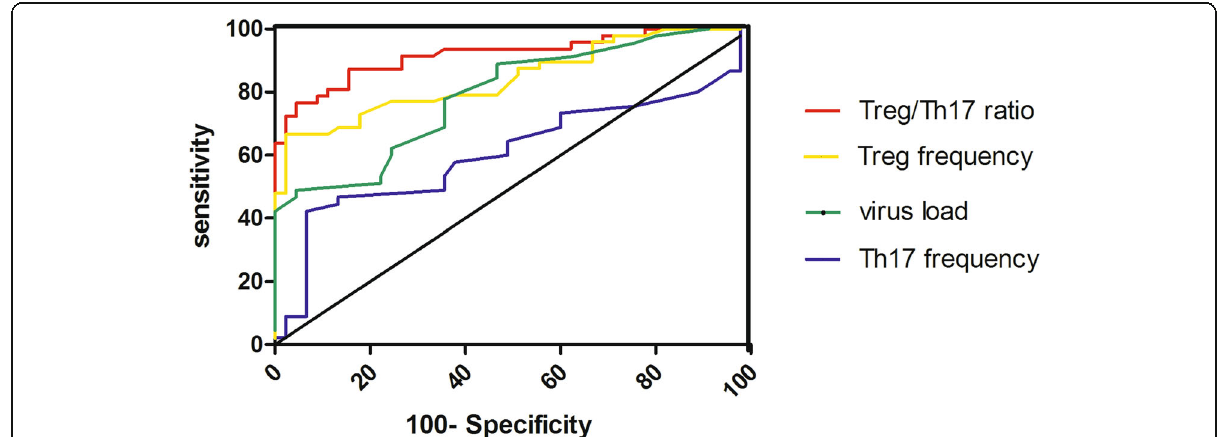
Fig. 4 ROC curves of the virus load,Treg cell frequencies,Th17 cell frequencies and the Treg/Th17 ratio for the prediction of